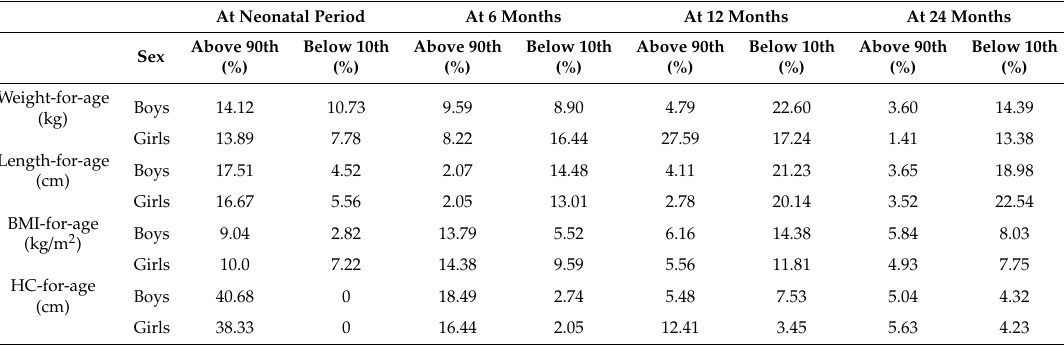
Table 2. Percentages of infants above the 90th percentile and below the 10th percentile of the WHO standards for weight-for-age, length-for-age, BMI-for-age, and head circumference-for-age, at neonatal period, 6 months, 12 months, and 24 months of age.